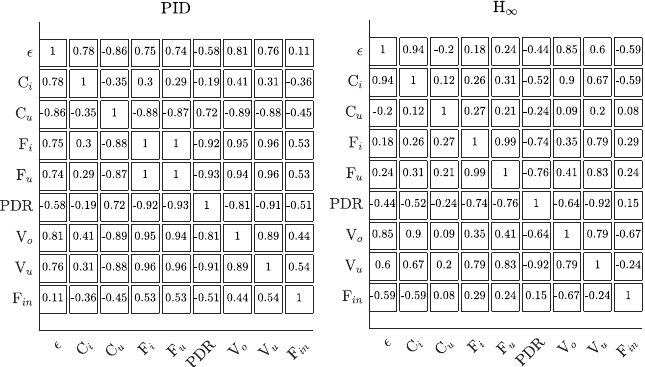
Figure A2. Correlation matrix of system parameters for the 2080–2550 s time period, with respect to the PID and H ∞ control solution. Here shown with numerical